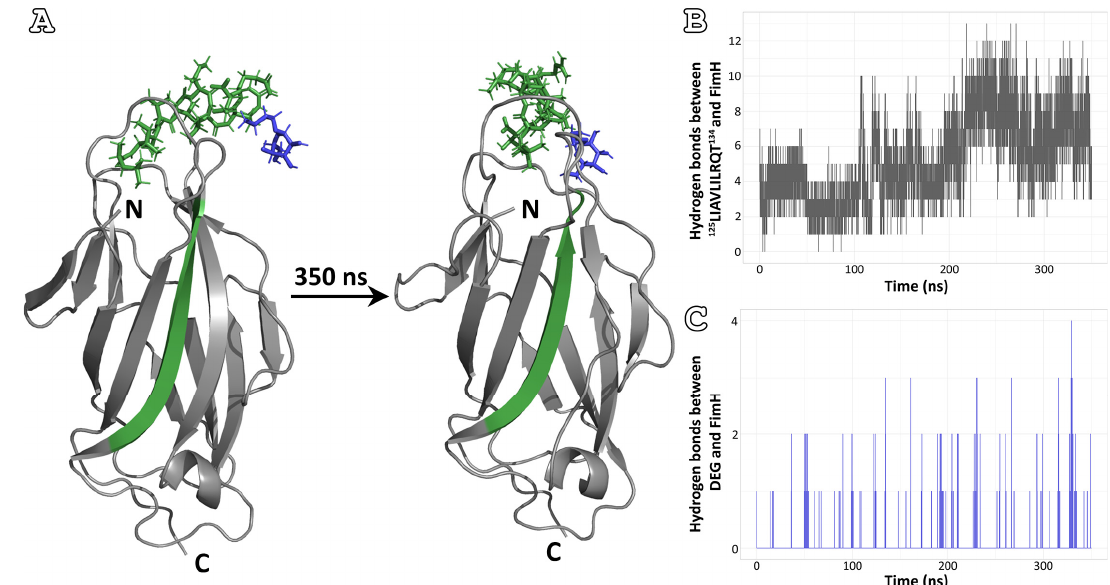
Figure 4. MD simulations of lectin domain-DEG- 125 LIAVLILRQT 134 complex . ( A ) First (0 ns, left) and last (350 ns, right) frames of MD simulations. 125 LIAVLILRQT 134 peptide-analogue is colored green, and DEG is colored blue (N: N-terminal, C: C-terminal). ( B ) The number of hydrogen bonds formed between 125 LIAVLILRQT 134 peptide-analogue and FimH lectin domain. More bonds are formed by the end of the simulation. ( C ) The number of hydrogen bonds formed DEG and FimH lectin domain. The number of hydrogen bonds between the two molecules fl uctuates during the simulation, with that being zero in most instances.